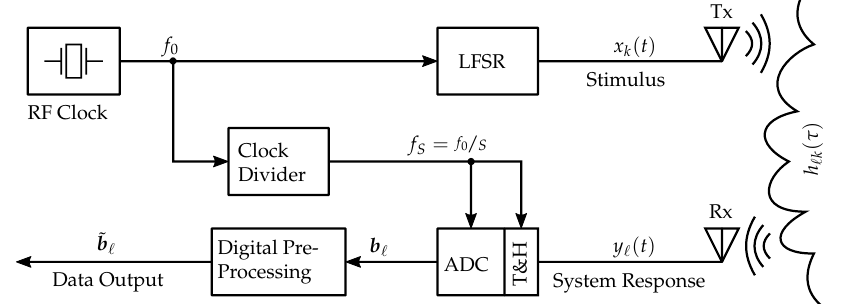
Figure 2. State-of-the-art MLBS UWB sensor block design.